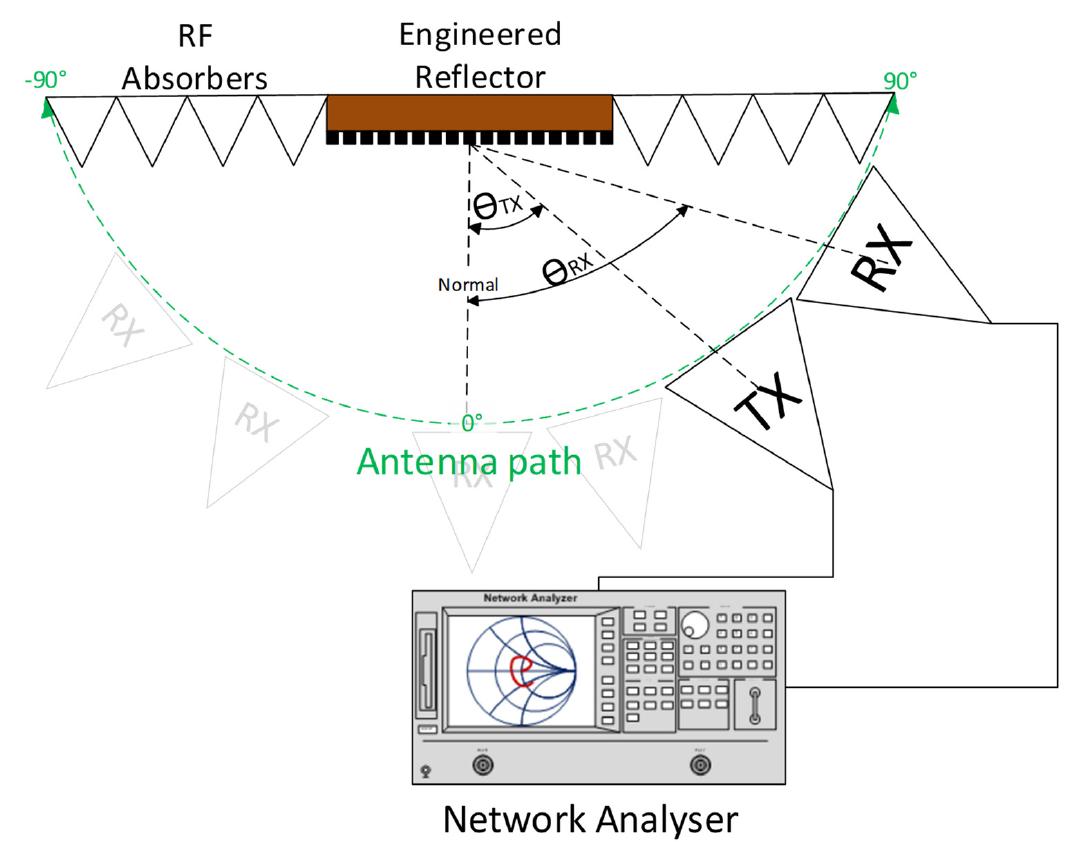
Figure 15. Bistatic RCS measurement setup with fixed transmitter (Tx).